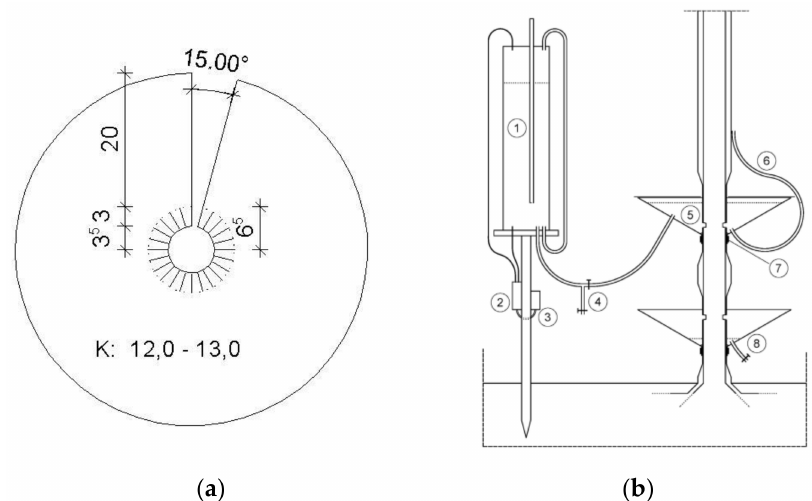
Figure 1. ( a ) Schematic of the cut tree experiment, 1 = Mariotte water supply, 2 = Differential pressure sensor, 3 = Data logger, 4 = Valve, 5 = Collar, 6 = Pipe for water level control, 7 = Lashing belt, 8 = Collar; ( b ) Prototype of a collar, K = Diameter, all dimensions in